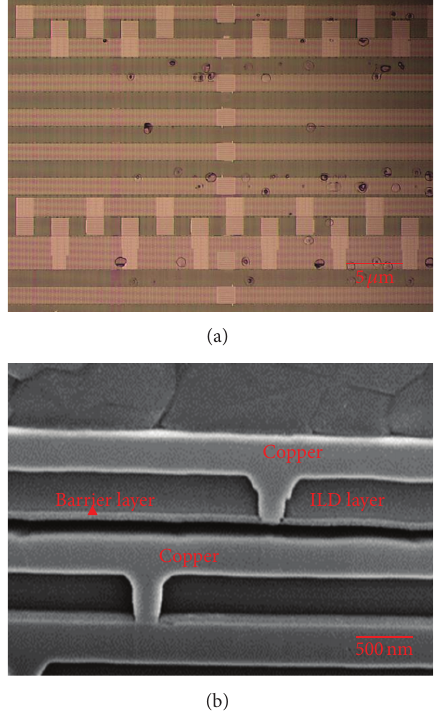
Figure 6: (a) OM image of bubble-like defects; (b) cross-section SEM images of a bubble defect.